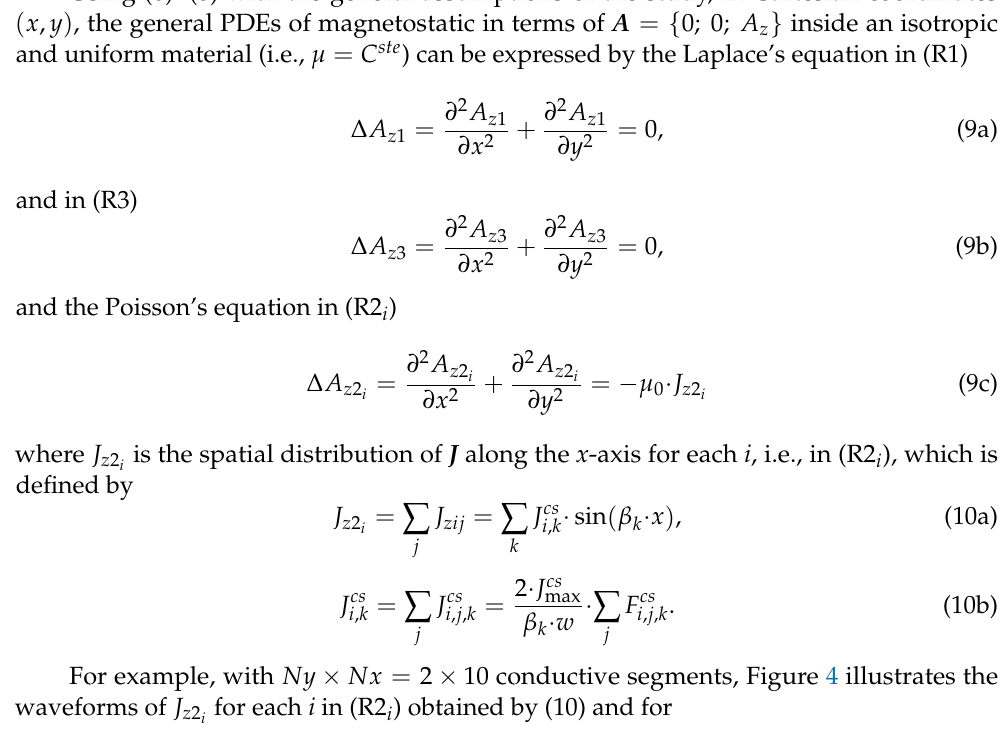
Figure 4. Spatial distribution of: ( a ) J z 2